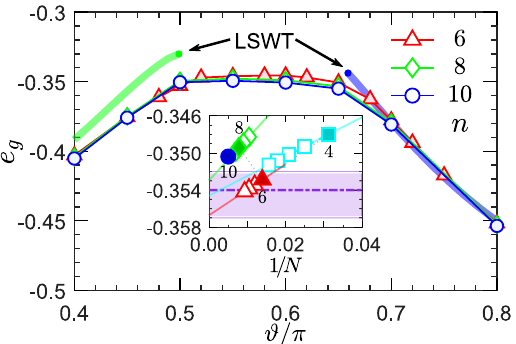
Fig. 4 Quantum ground-state energy. DMRG result of e g under three XC clusters where the circumferences n are 6 (red triangle), 8 (green diamond), and 10 (blue circle). The thick belts are the energy of the zigzag order (green belt) and stripy order (blue belt) obtained by the linear spin-wave theory (LSWT). Inset: Extrapolation of energy for Γ model. For each circumferences n the energy is linearly decreasing with 1/ N and the special cases ( L x / L y = 2) are marked by fi lled symbols. The extrapolated values fall in the purple band centered at −